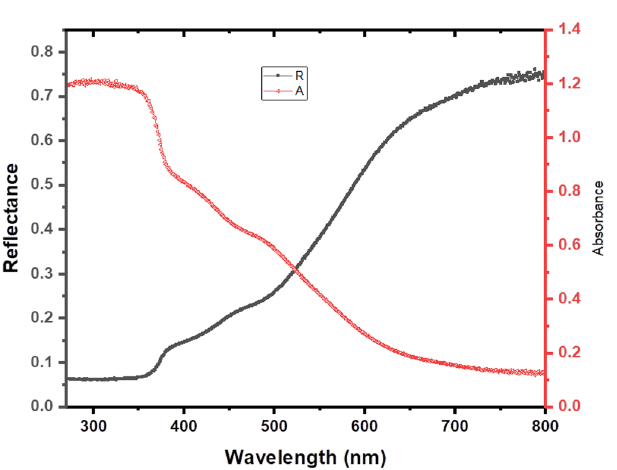
Figure 3. X-ray photoelectron spectroscopy spectra of the prepared Zn–Fe LDH.